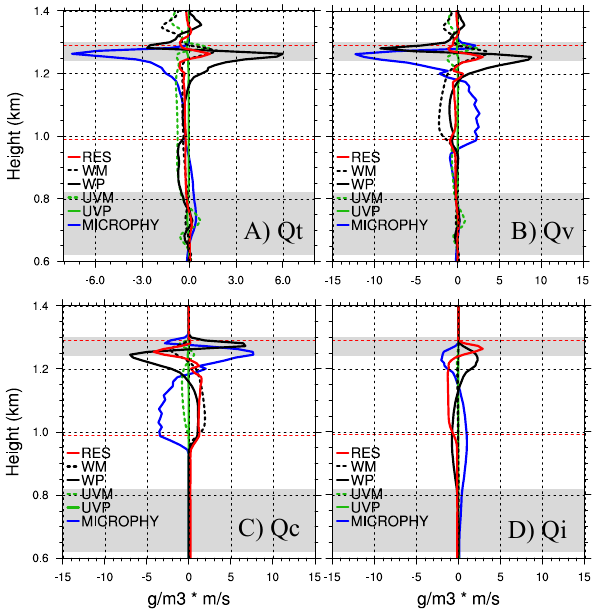
Fig. 14. Processes that contribute to 15-min averaged water content tendencies above the surface layer for the square box, in units of gm − 3 day − 1 . Note net contribution due to microphysics for total water in (A) is equal to sedimentation, as condensational terms can- cel. The residual is equal to subgrid scale mixing plus diffusion. Mean advection terms (denoted with WM, UVM) are calculated by horizontally averaging tendencies. Horizontal eddy advection (UVP) is calculated as the divergence of fluxes across the domain. Vertical eddy advection (WP) is the divergence of the vertical eddy flux. Note change in scale in (A) . Entrainment zones indicated with gray shading. (A) Total water. (B) Water vapor. (C) Cloud liquid water. (D) Cloud ice water. Cloud layer top and base indicated by red dashed lines.